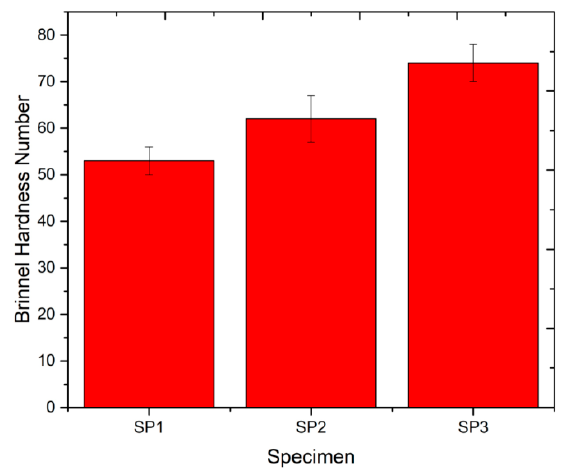
Figure 3. Brinell hardness number (BHN) for tested composite